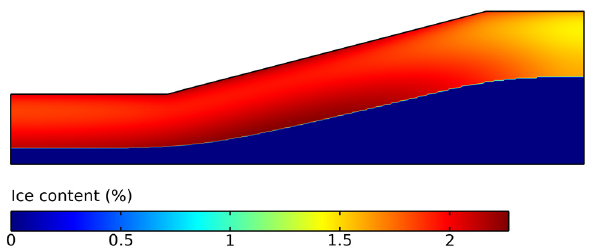
Figure 8. Ice content distribution of the soil at 97 h.